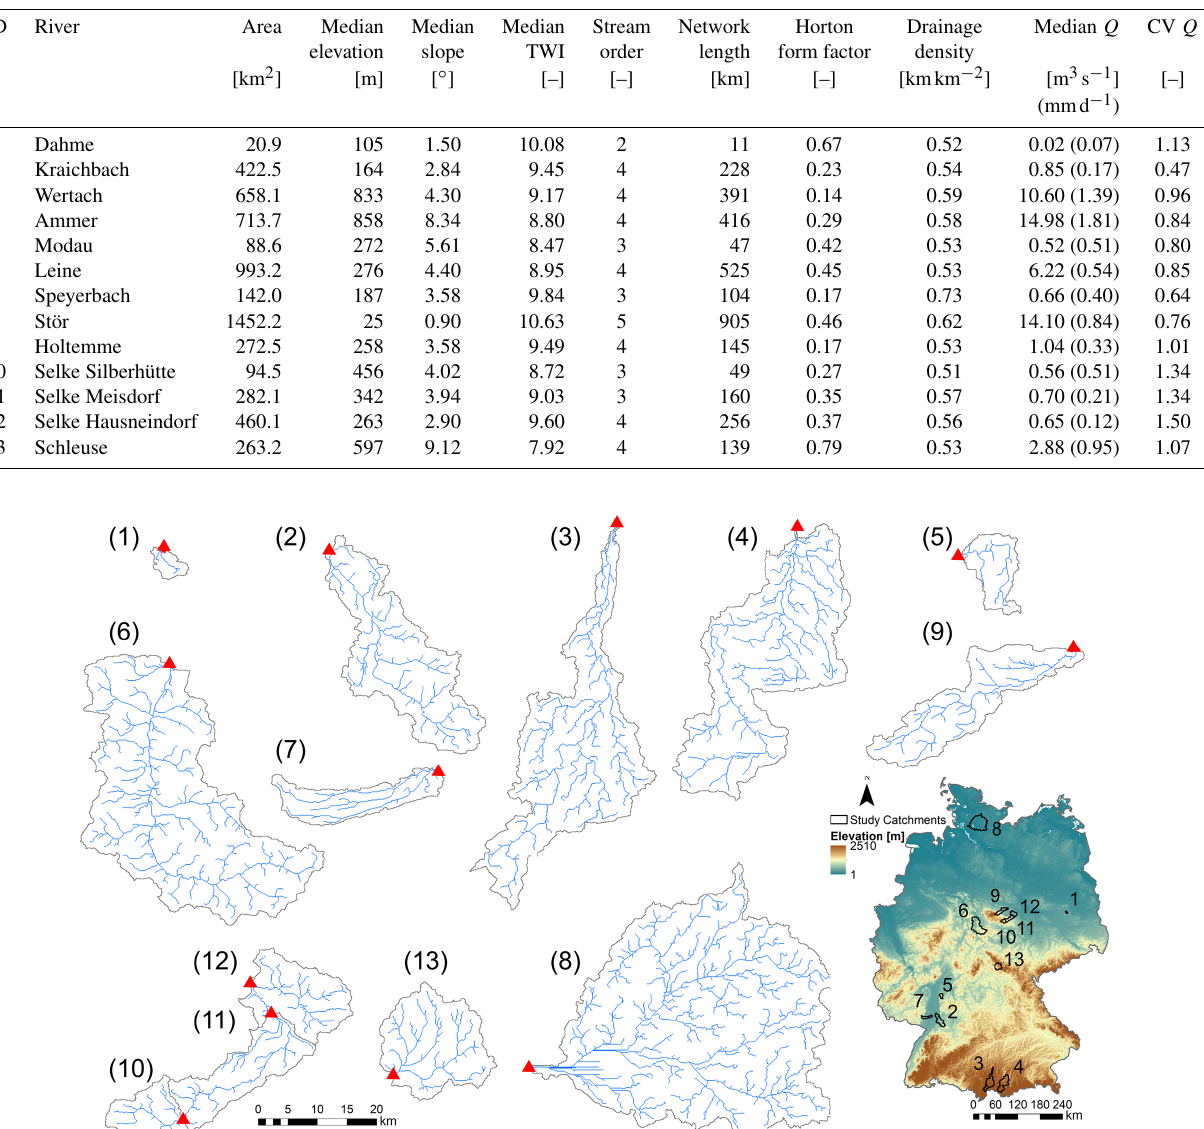
Table 2. Catchment properties summary: catchment area, median elevation, slope and topographical wetness index (TWI), maximum Strahler stream order, Horton form factor, drainage density, median discharge at the basin mouth over time ( Q ) with the corresponding runoff (area specific discharge) between brackets, and the coefficient of variation in the discharge in time (CV Q ). The latter variable CV Q integrates the frequency of runoff events and the differences in recession constant (so the catchment’s “flashiness” in response to rainfall) (Botter et al., 2013).